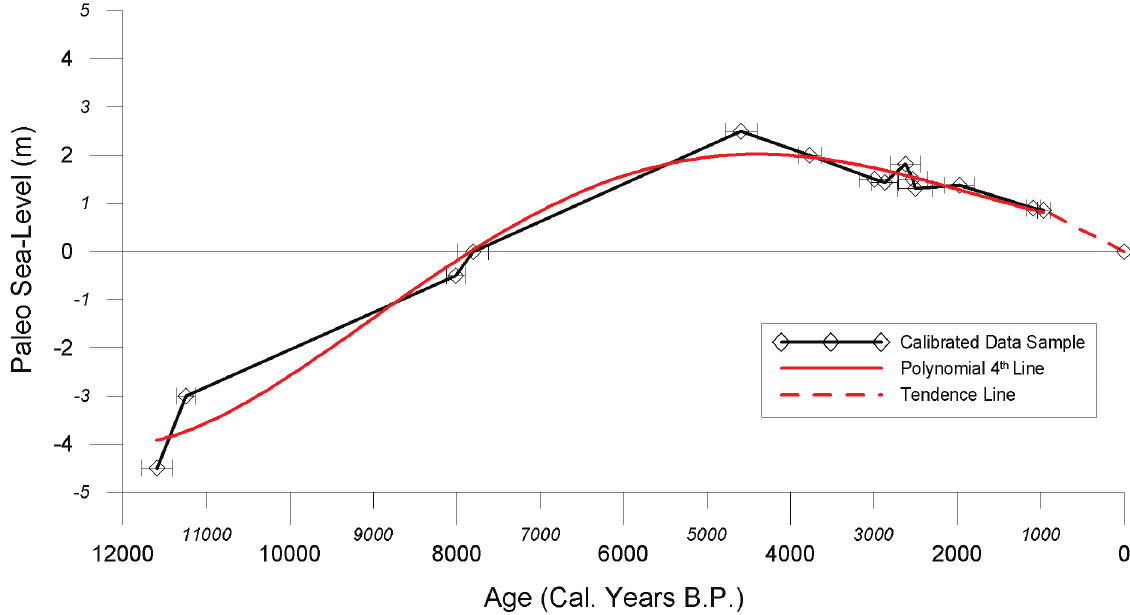
Figure 4 - Relative sea-level variation curve for the coast of the state of Rio de Janeiro, southeastern Brazil. Black Color: Curve constructed from a linear trend line defined by averaging the calibrated ages at 2 σ. Red Color : Curve constructed by a fourth- degree